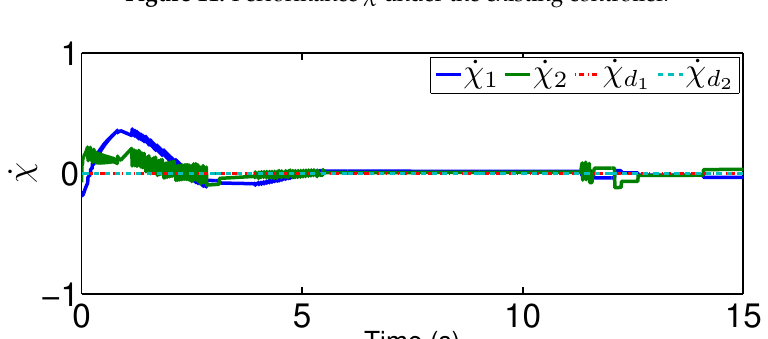
Figure 11. Performance χ under the existing controller.